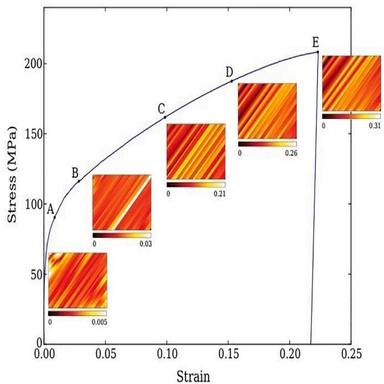
Evolution of plastic slip bands at different stages . The copyright permission for this figure has been granted.